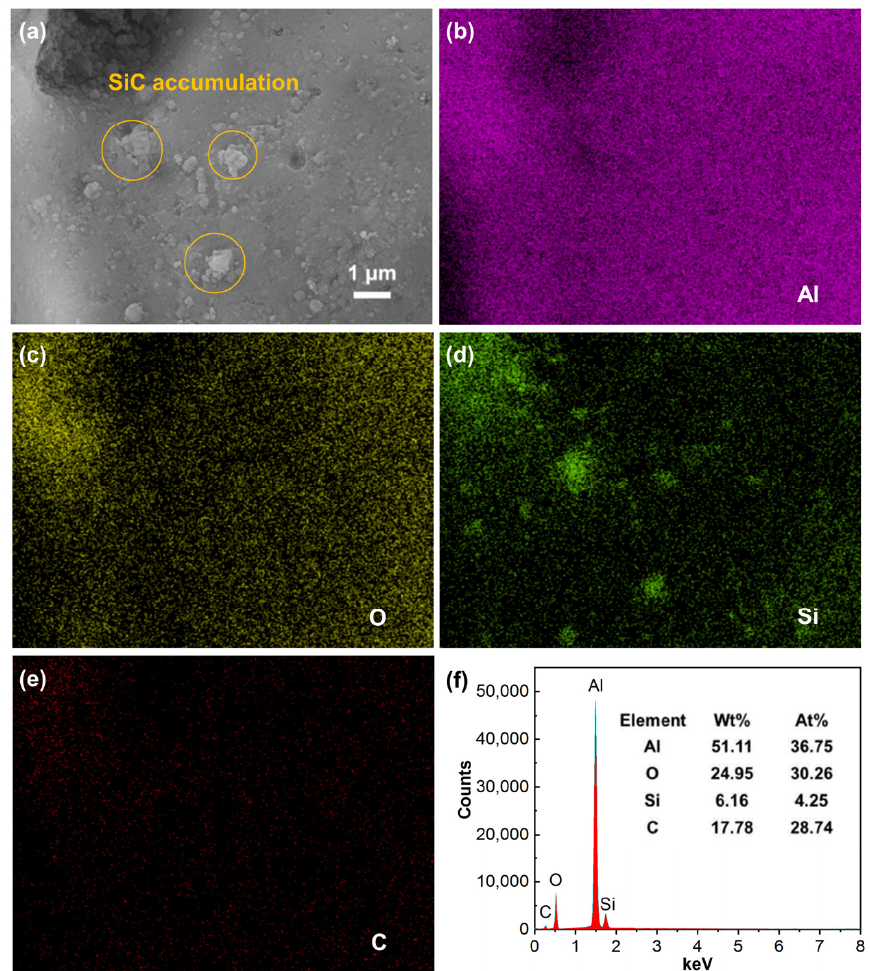
Figure 6. SEM morphology and elemental mappings of sample S20: ( a ) nanoscale surface morphology of sample S20; ( b – e ) Al, O, Si and C mappings; ( f ) EDS spectrum of the whole area.